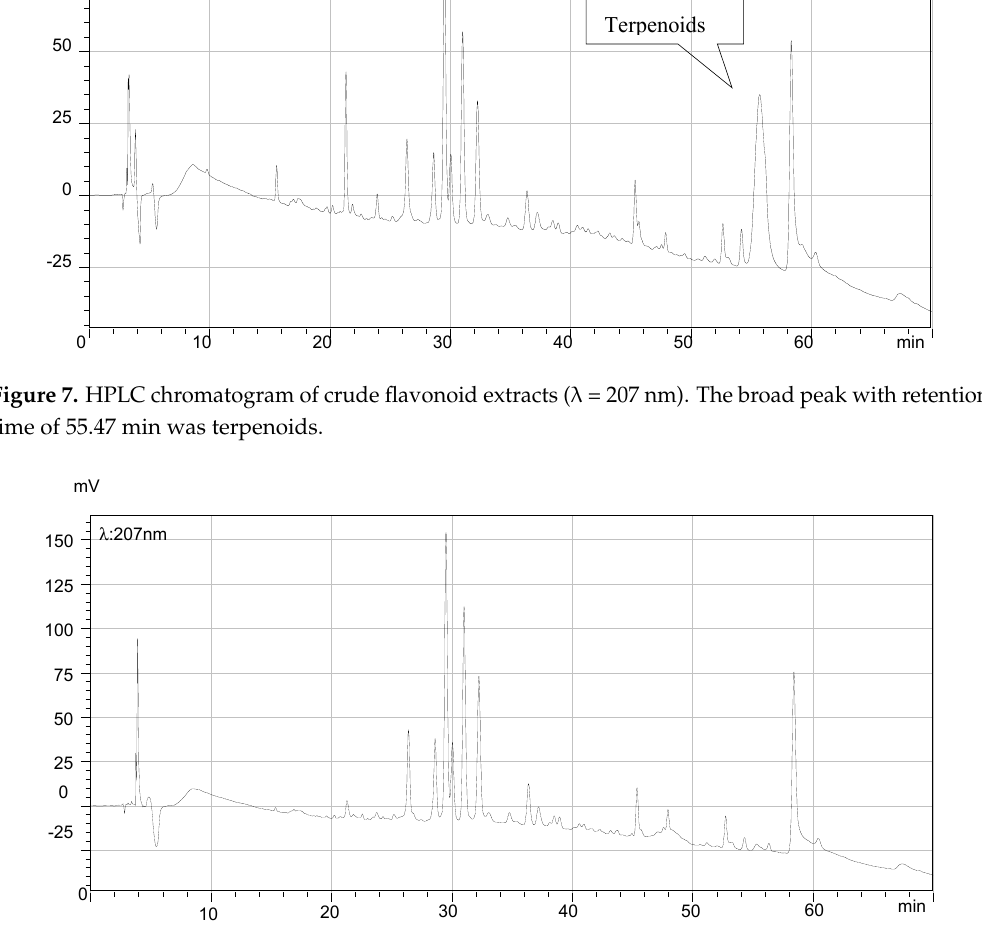
Figure 8. HPLC chromatogram of final products ( λ = 207 nm). Comparing with Figure 7, the broad peak with a retention time of 55.47 min disappeared. Table 4. Peak assignment for the compounds in the final product and the crude flavonoid extracts of Scorzonera austriaca . Peak No.